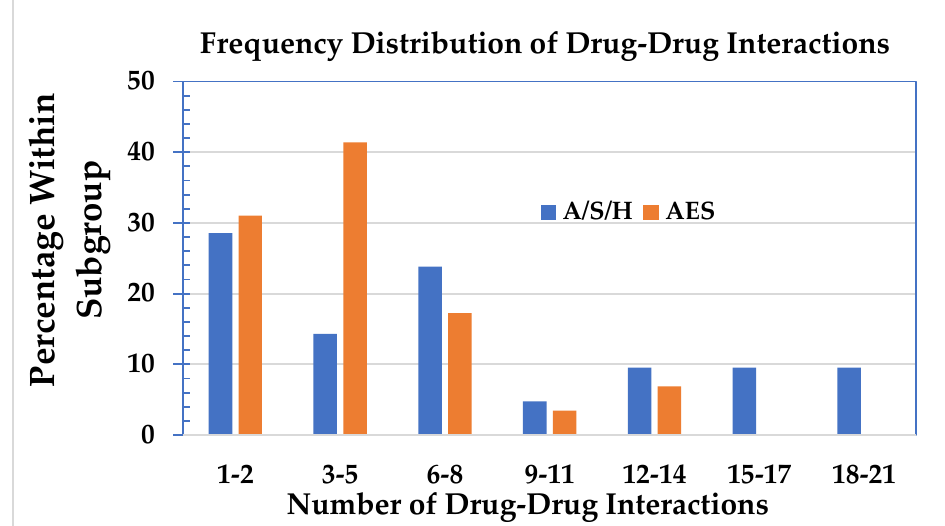
Figure 4. The mean number of DDI in the A/S/H subgroup was 7.7 (SD: 6.5, range 0 – 21, 95% CI: 4.8–10.7) and in the AES subgroup 2.8 (SD: 1.28, range 0–17, 95% CI: 2.2–3.4). The 95% CI: 4.8 – 10.7) and in the AES subgroup 2.8 (SD: 1.28, range 0 – 17, 95% CI: 2.2 – 3.4). The